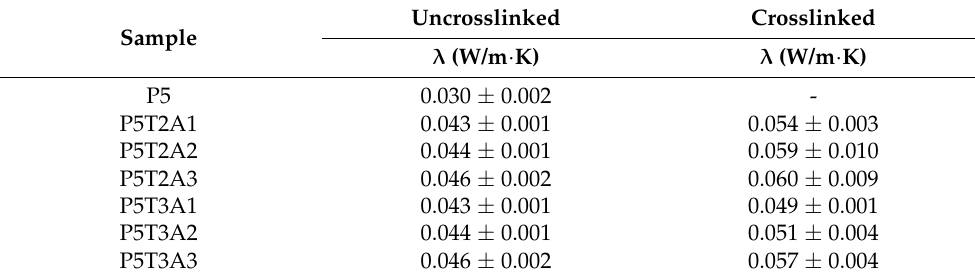
Table 3. Thermal conductivities of uncrosslinked and crosslinked aerogels in a dried state. Sample